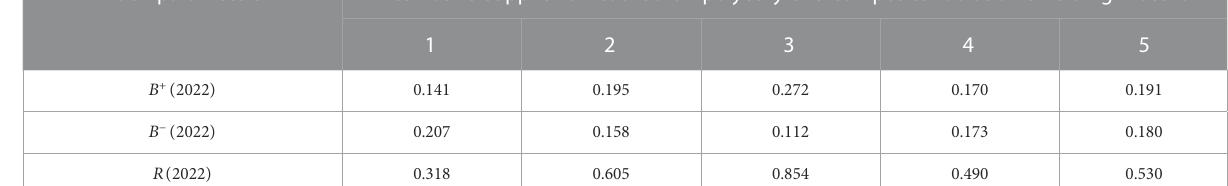
TABLE 4 Comparison of TOPSIS-ANP grey relational projection values and closeness. Index